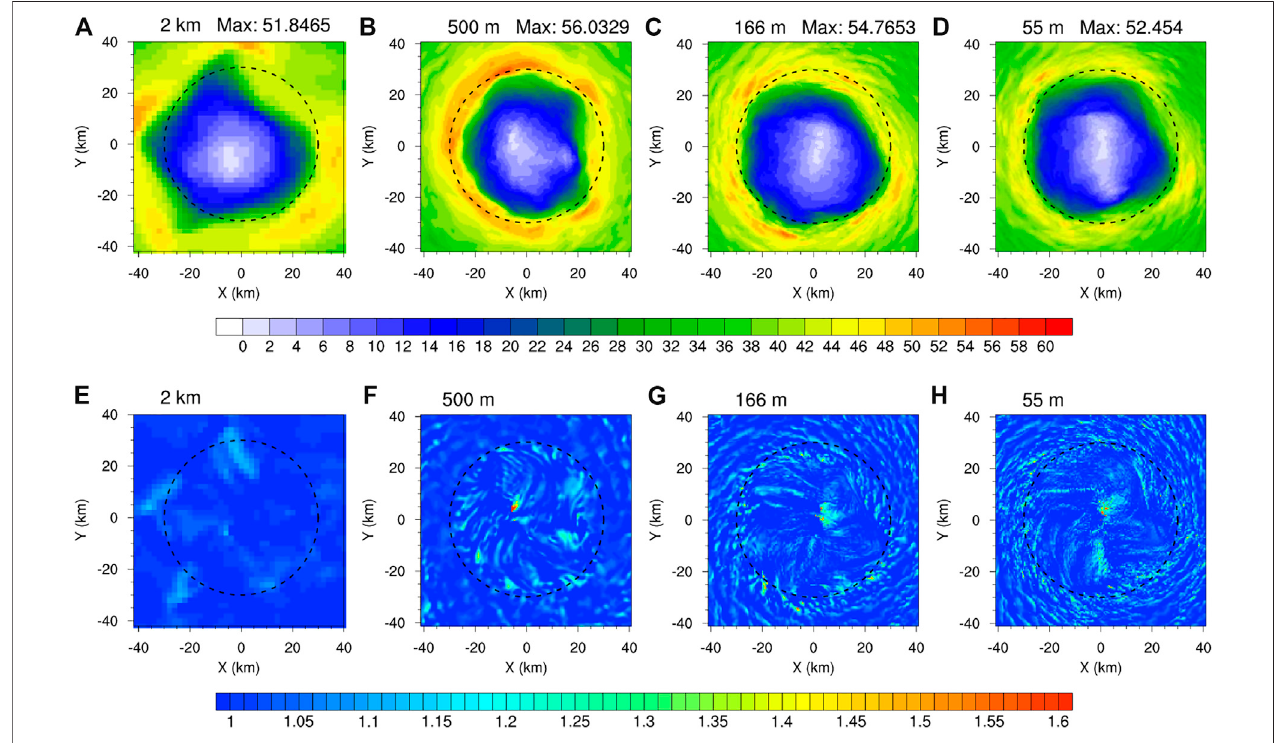
FIGURE 3 | Horizonal cross-section of 2 min average 10-m wind speed (m s − 1 ) at t (cid:2) 9 h of the simulation from the grid spacings of (A) 2 km, (B) 500 m and (C) 166 m (D) 55 m, respectively; (E) – (H) are the same as (A) – (D) but for the gust factor. Dash circles indicate the radius of 30 km from the TC center.